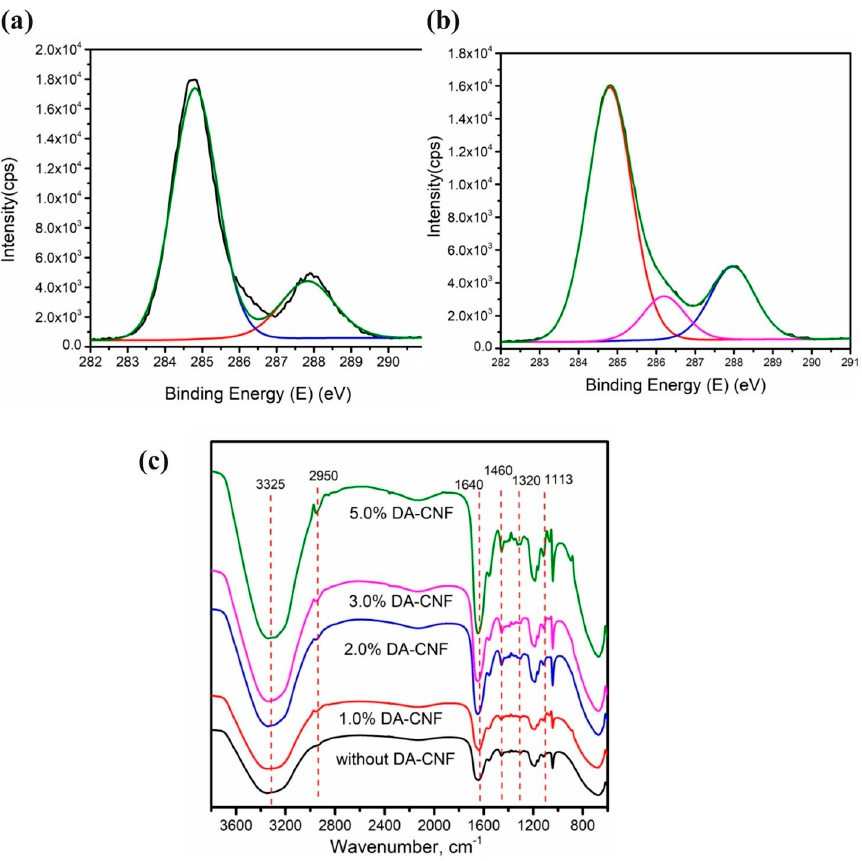
Figure 4. Characteristics of DA-CNF based hydrogel. ( a ) XPS of hydrogel without DA-CNF. ( b ) XPS of hydrogel with 3.0% DA-CNF. ( c ) FTIR spectra of